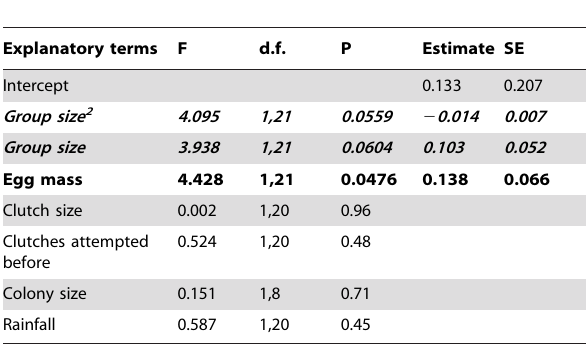
Table 3. Factors affecting yolk